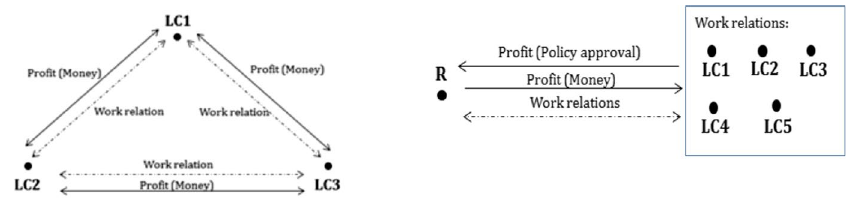
As a facilitator , lower-level civil servants are forced by higher-level officials to execute the transaction; for example, Fig. 4, case No. 74. In this bid-rigging case between a local government and a private company (PCD), civil servants were forced by the head of region (R) to execute the transaction with the private actor as a facilitator. The senior civil servant (SCS) can be considered a facilitator between (R) and civil servant (CS). The subordinate acts as the powerful actor’s accomplice. Lower-level civil servants do not often share in any direct profit from the exchange between the superior and private actor: they are simply forced to comply.